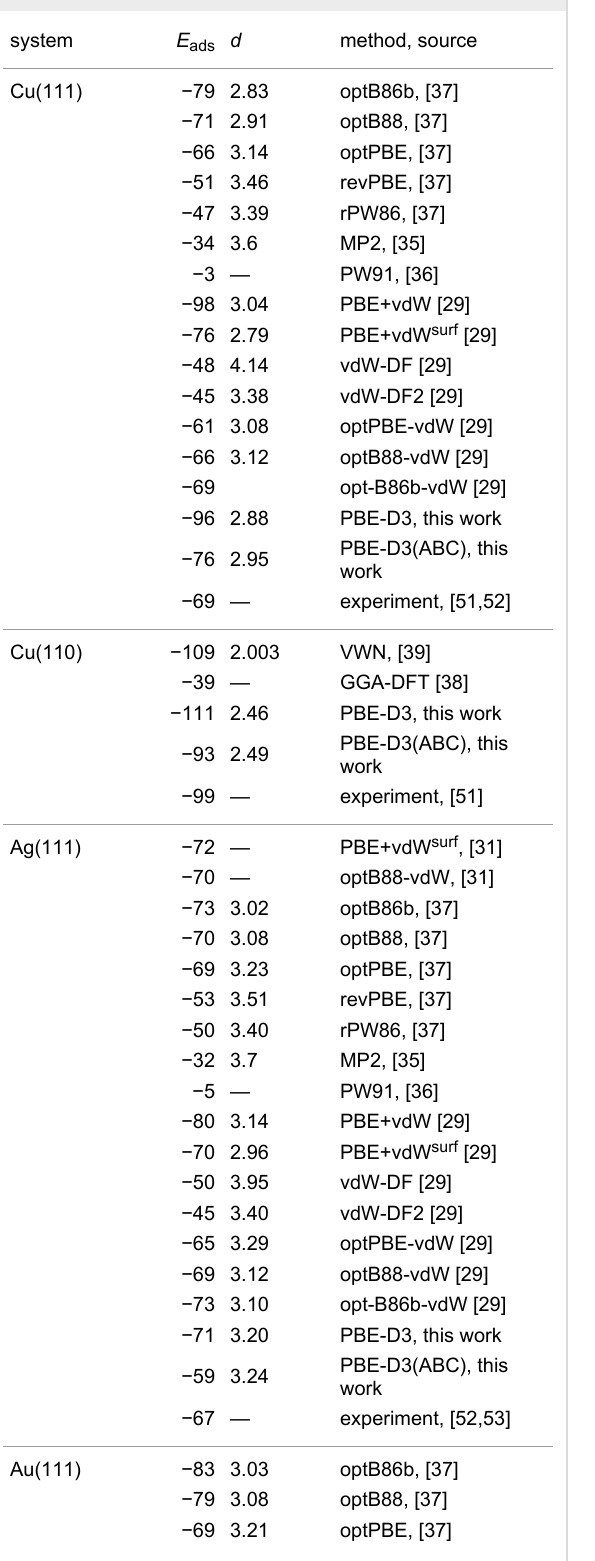
Table 3: Comparison of adsorption energies E ads in kJ/mol and adsorption distances d in Å with available theoretical and experimental data. (continued)